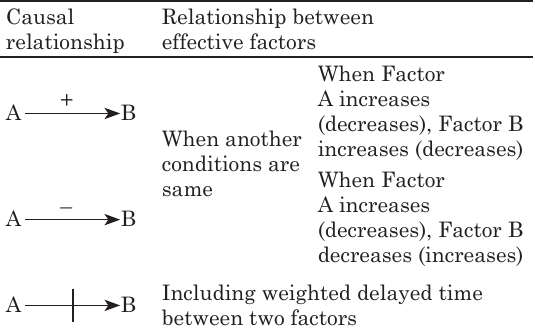
table 1. Causal loop diagram (sterman, 2000) Causal